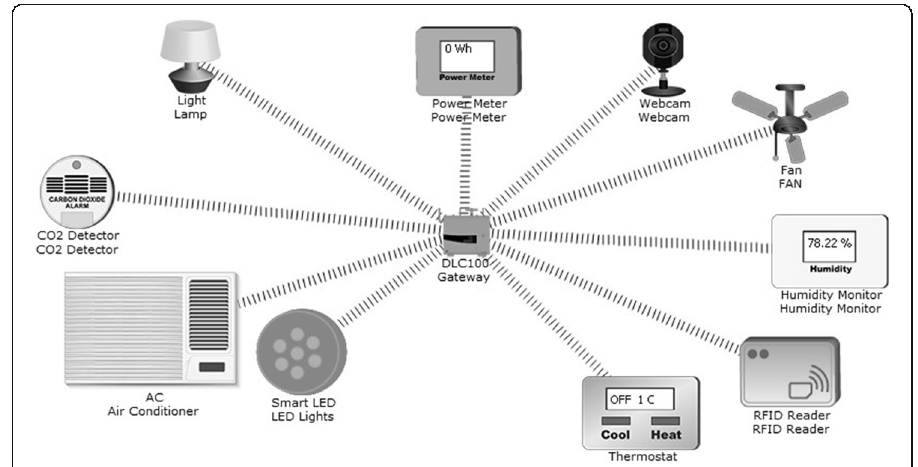
Fig. 5 Components in IoE based Classroom Setup. The various components are simulated using Cisco Packet Tracer Software. The dashed line connecting the components and gateway represents wireless